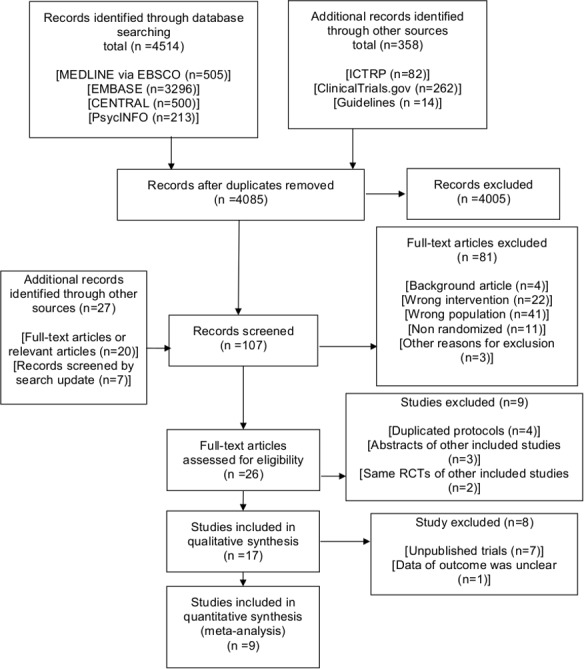
PRISMA 2009 flow diagram.CENTRAL: Cochrane Central Register of Controlled Trials; ICTRP, International Clinical Trials Registry Platform; RCTs, randomized controlled trials